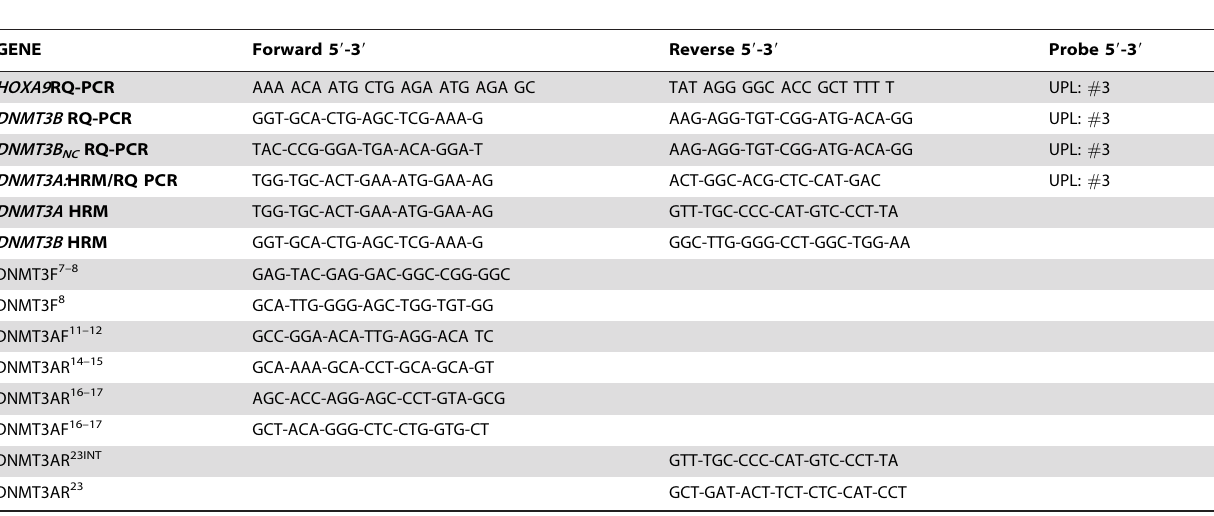
Table 2. Sequences of the different primers and